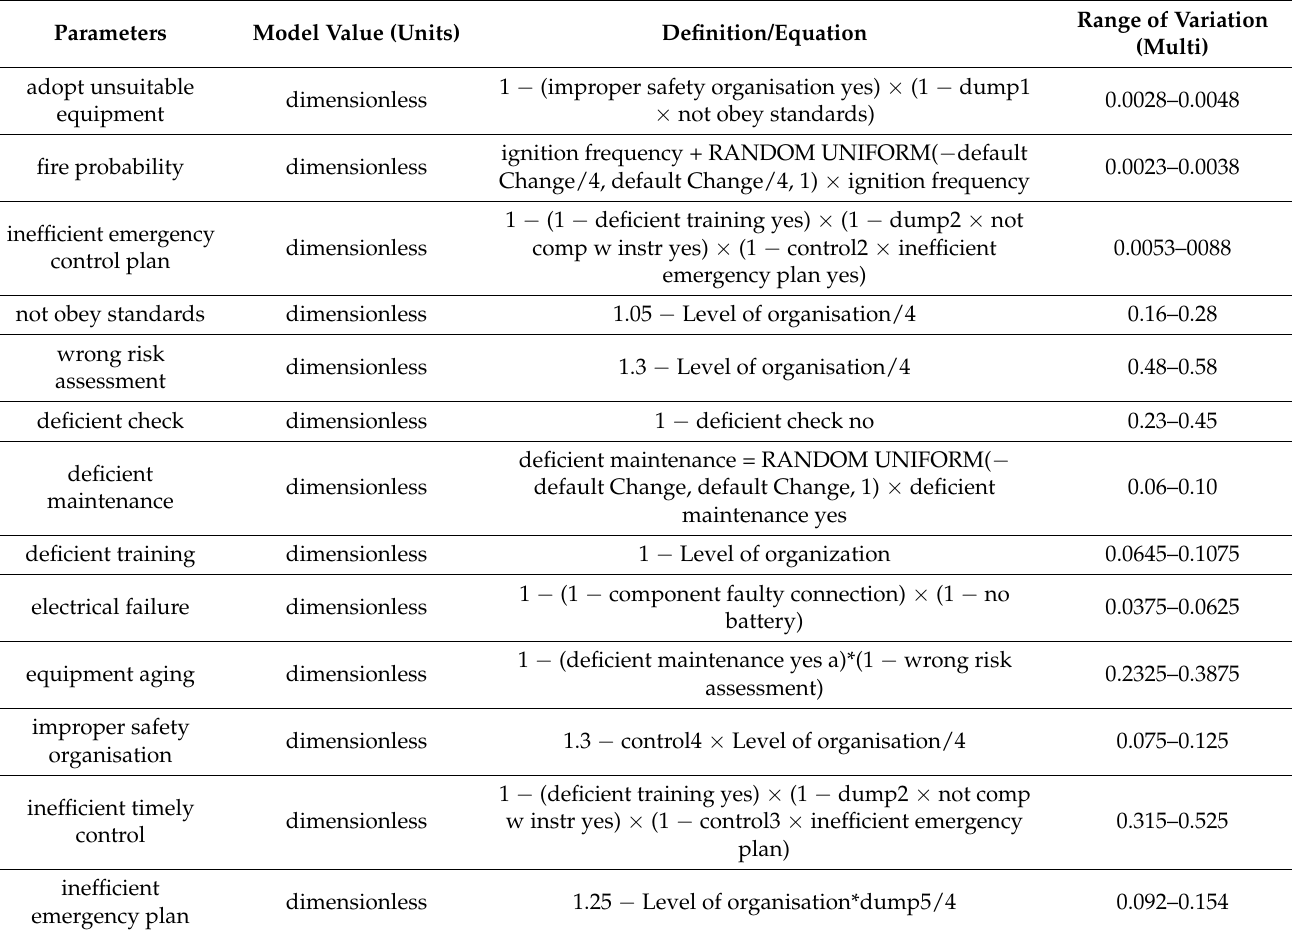
Table A6. List of parameters in System Dynamics